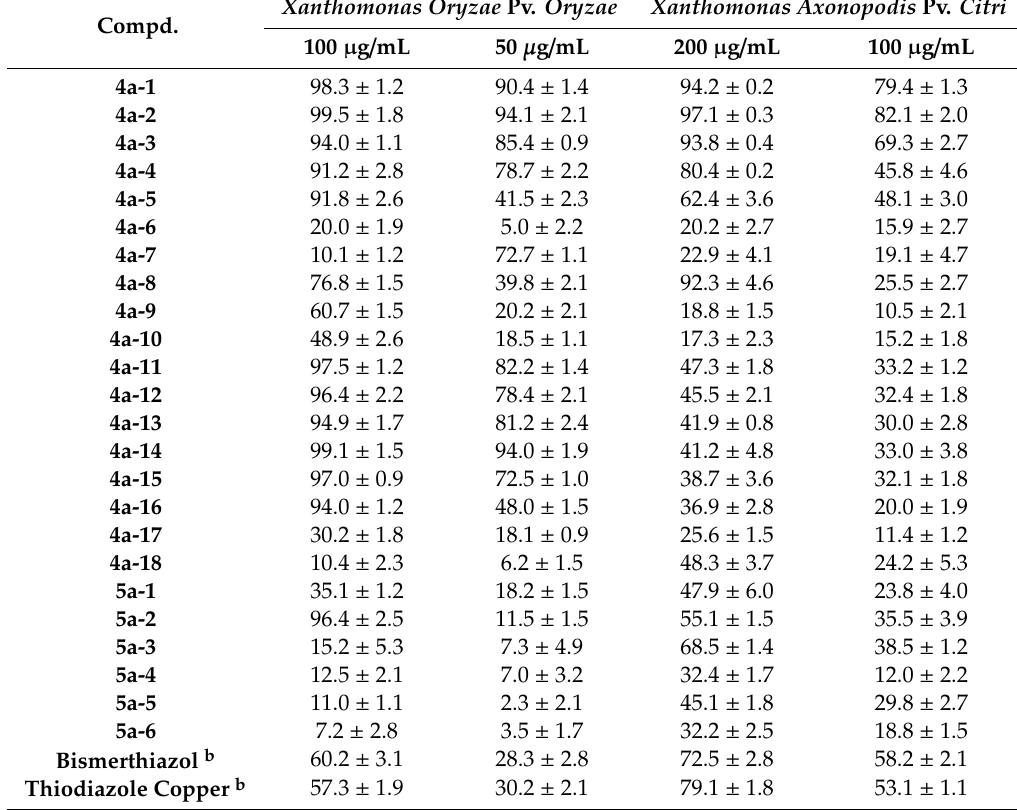
Table 1. Inhibition rate (%) of target compounds against Xanthomonas oryzae pv. oryzae and Xanthomonas axonopodis pv. citri a . Compd.